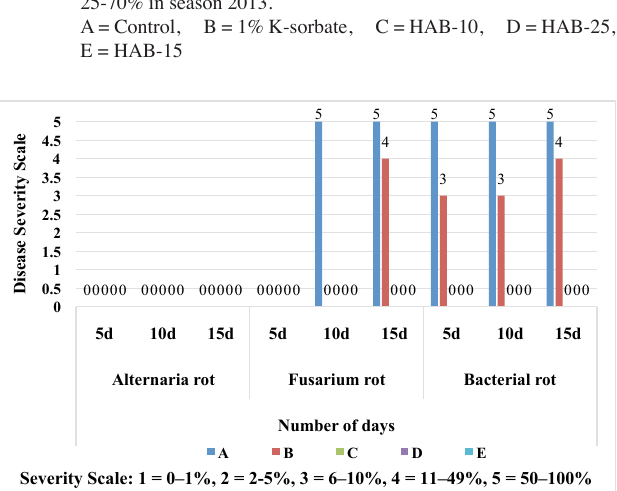
Severity Scale: 1 = 0–1%, 2 = 2-5%, 3 = 6–10%, 4 = 11–49%, 5 = 50–100% Fig. 3B: Effect of fluorescent Pseudomonas species on disease severity of tomato stored at 23±4 ºC with relative humidity in the range of 25-70% in season 2014. A = Control, B = 1% K-sorbate, C = HAB-10, D =